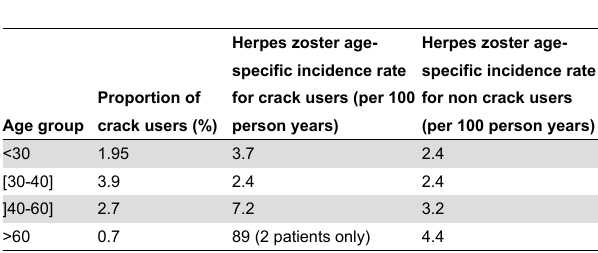
Table 1. Predictive factors of herpes zoster in HIV patients in French Guiana.